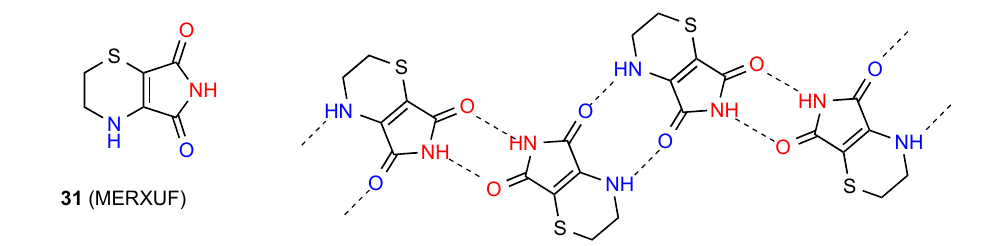
Figure 12. Structure adopted by compound 31.